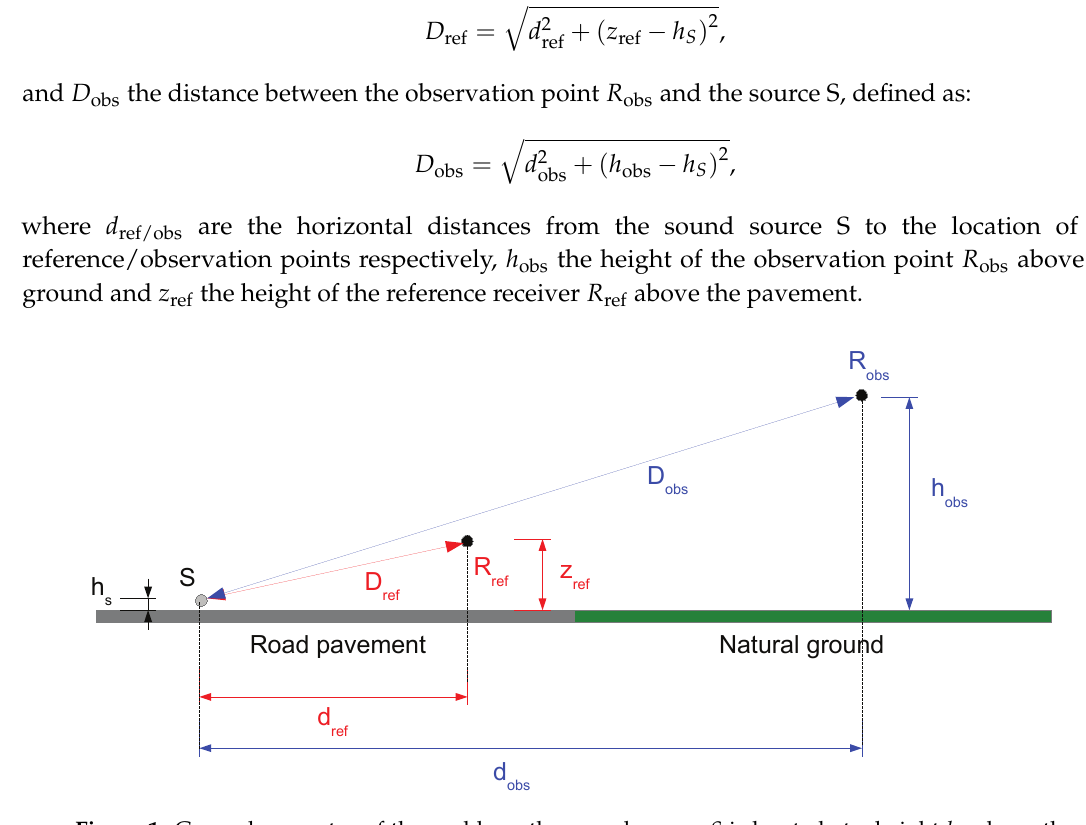
Figure 1. General geometry of the problem: the sound source S is located at a height h S above the pavement; the reference receiver R ref is located at a height z ref above the ground and at a distance D ref from the source S (at a horizontal distance d ref from the source); the observation point R obs is located at a height z obs above the ground and at a distance D obs from the source S (at a horizontal distance d obs from the